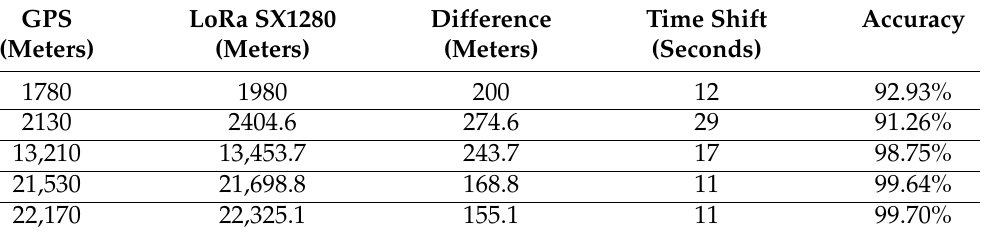
Table 3. The LoRa SX1280 2.4 GHz distance measurement compared to the GPS using a long-range weather